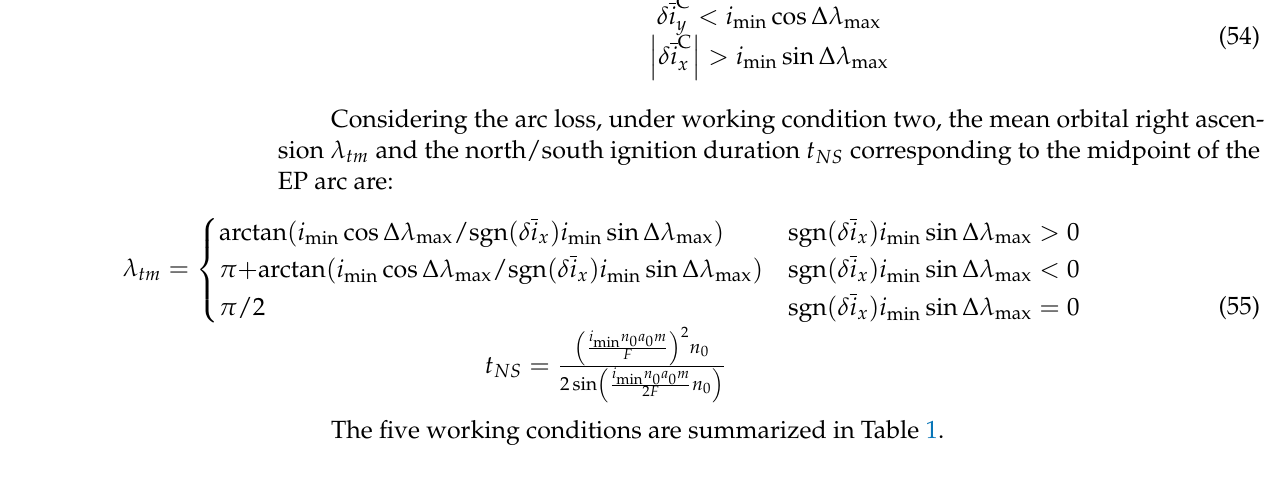
Table 1. Summary of five working